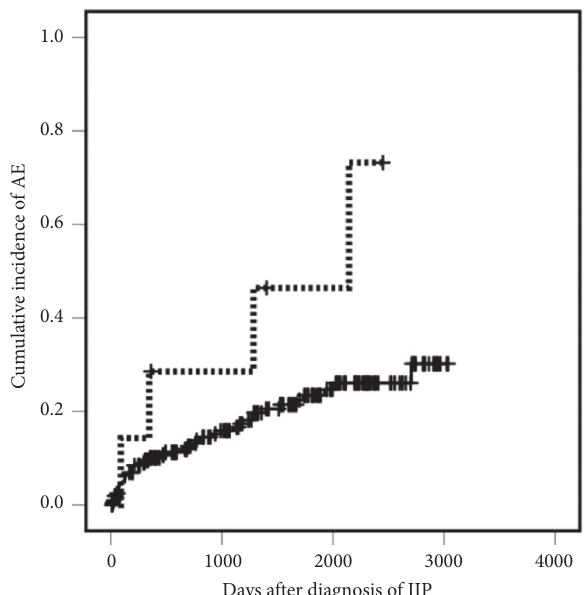
Figure 2: Kaplan–Maier curves showing the cumulative incidence of acute exacerbation (AE) in idiopathic interstitial pneumonias (IIPs). The median observation period from the date of bron- choalveolar lavage for the diagnosis of IIPs in total cases, IIPs with a lower hemosiderin score (HS), and the IIPs with a higher HS was 1239days, 1214days, and 1284days, respectively. AE occurred significantly earlier in IIP cases with a higher HS ( ≥ 61.5; dotted line) than IIPs cases with a lower HS ( < 61.5; solid line, log-rank test, p � 0.026). The six-year occurrence rate of AE was 73.2% in IIPs with a higher HS and 26.1% in IIPs with a lower